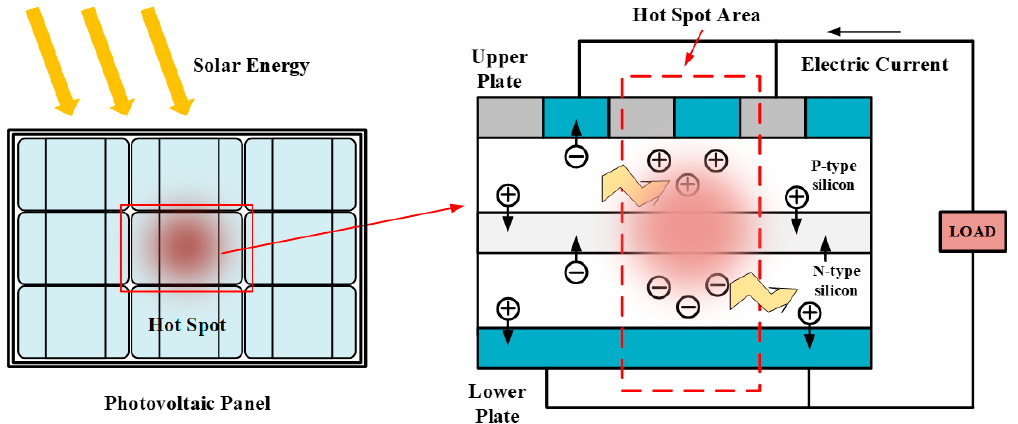
Figure 3. The process of the formation of hotspots on PV solar panels.